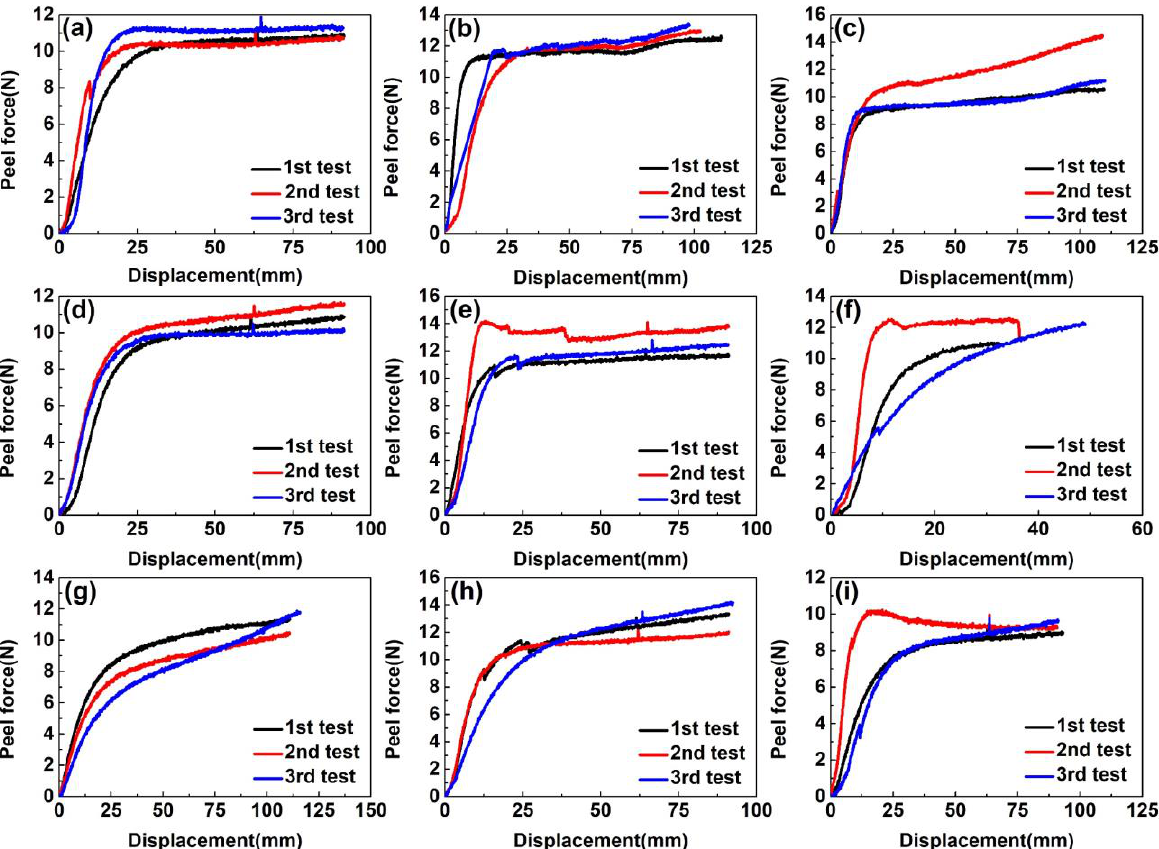
Figure 5. The peel curve of CFRP/EPDM composites. ( a ) CFRP/EPDM/DCP, 160 °C, 20 min. ( b ) CFRP/EPDM/DCP/S, 160 °C, 20 min. ( c ) CFRP/EPDM/DCP/TAIC, 160 °C, 20 min. ( d ) CFRP/EPDM/DCP, 160 °C, 30 min. ( e ) CFRP/EPDM/DCP/S, 160 °C, 30 min. ( f ) CFRP/EPDM/DCP/TAIC, 160 °C, 30 min. ( g ) CFRP/EPDM/DCP, 160 °C, 40 min. ( h ) CFRP/EPDM/DCP/S, 160 °C, 40 min. ( i ) CFRP/EPDM/DCP/TAIC, 160 °C, 40 min.